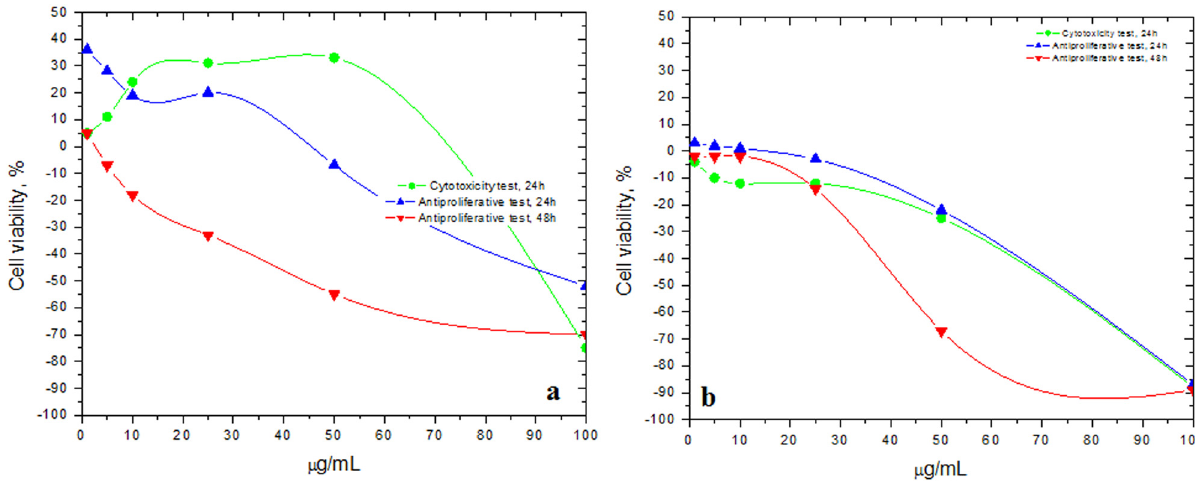
Figure 4: Cytotoxic and antiproliferative e ff ects ( cell viability, % ) of Slae26 tested on ( a ) mammary gland cell line MCF - 12A and ( b ) human breast tumor cell line BT - 20, compared to the control negative cells; n = 3, ± SD ( % ) .